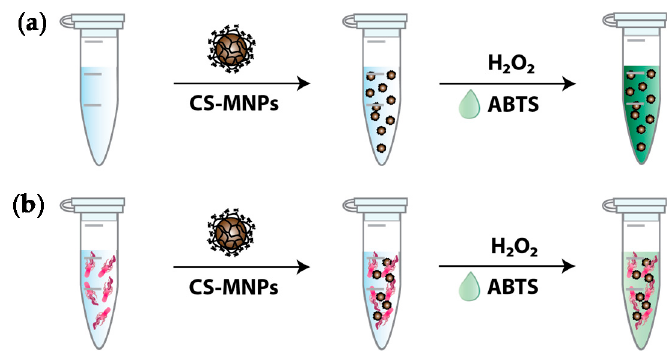
Figure 3. Schematic representation of the CS-MNPs-based colorimetric bacteria detection ( a ) in the absence or ( b ) in the presence of bacterial cells.